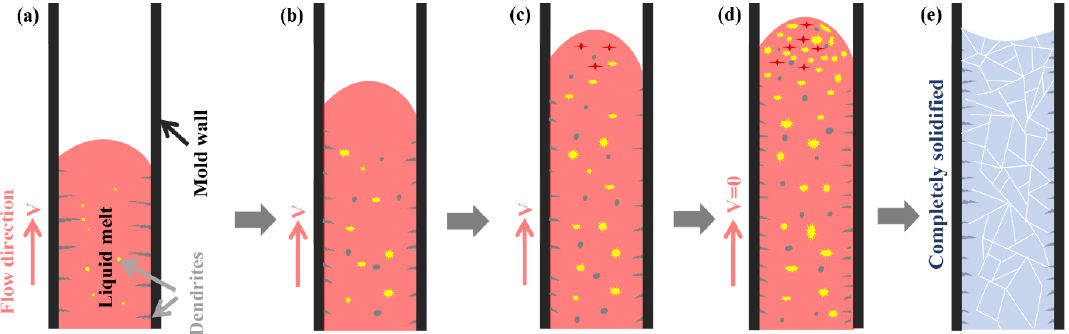
Figure 11. The cessation mechanism of flow for Ti ‐ 6Al ‐ 4V ingot: ( a – c ) filling step in which the liquid metal is in motion; ( d ) stagnant step in which the velocity of liquid metal is zero; ( e ) completely solidified step.